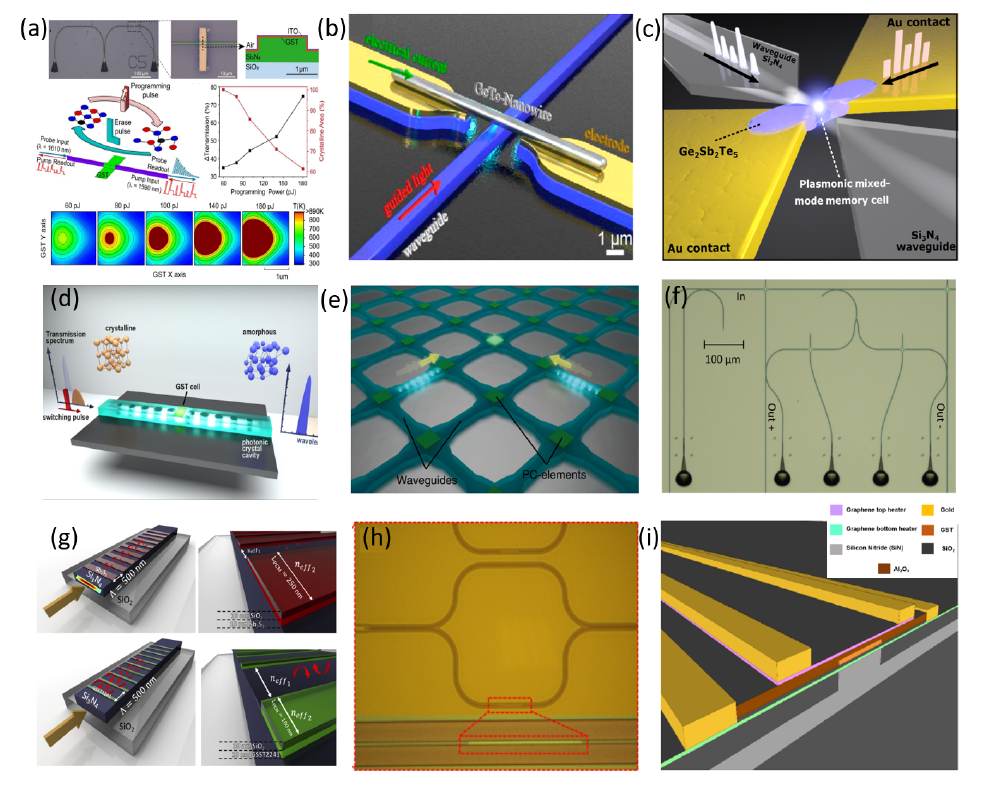
Figure 8. ( a ) Illustration of an all-optical nonvolatile photonic integrated memory based on GST; reproduced from [190] under a CC BY 4.0 license. ( b ) GeTe-based nanowire on a SiN waveguide; reprinted with permission from [192], ©2016 American Chemical Society. ( c ) A combination of GST with partially etched SiN rib waveguide-integrated plasmonic nanogap; reproduced from [184] under a CC BY 4.0 license. ( d ) GST-based SiN photonic crystal nanobeam cavity; reprinted with permission from [193], ©2018 American Chemical Society. ( e ) Image of an all-optical calculator, a photonic abacus; reproduced from [195] under a CC BY 4.0 license. ( f ) SiN waveguides with GST acting as on-chip matrix multiplication as part of a computationally specific integrated photonic hardware accelerator (tensor core); reproduced from [197] under a CC BY 4.0 license. ( g ) Schematic of low-loss nonvolatile SiN photonic-integrated Bragg grating based on Sb 2 S 3 and GSST; reproduced from [204] under a CC BY 4.0 license. ( h ) Microscope image of a SiN MZI with a Sb 2 S 3 cell deposited in one of the arms; reproduced from [207] under a CC BY 4.0 license. ( i ) Schematic of an integrated photonic graphene microheater for phase change chalcogenides on SiN building blocks; reproduced from [215] under a CC BY 4.0